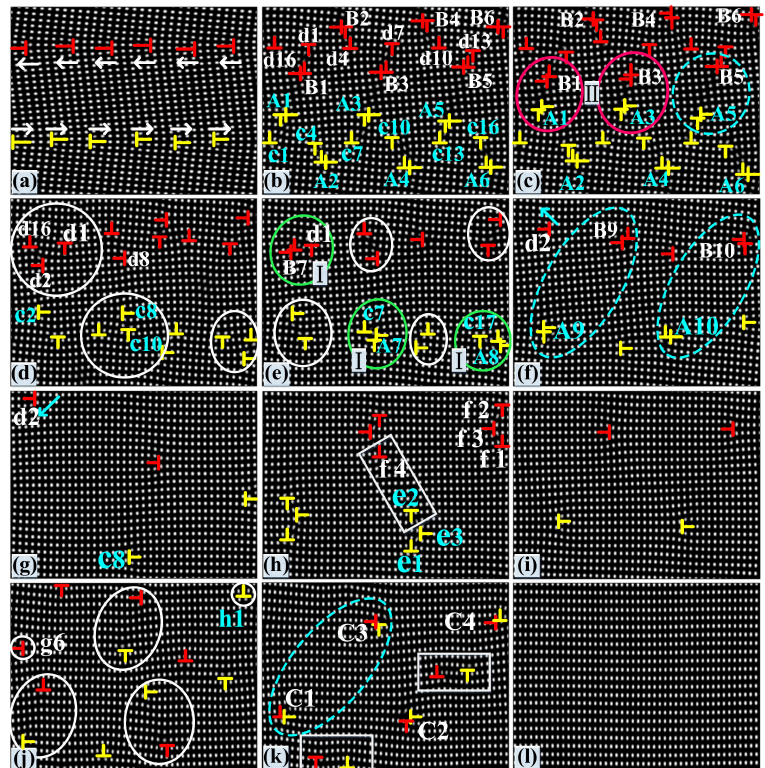
Figure 7. The evolution of the dislocations in sample B. The ( a – l ) corresponding time steps are t * = 38,000; t * = 48,100; t * = 48,200; t * = 48,700; t * = 49,000; t * = 49,600; t * = 55,300; t * = 67,200; t * = 68,000; t * = 79,600; t * = 81,200; and t * = 86,000. The pink solid circle area is a type II semi- annihilation dislocation reaction; the full-annihilation of the dislocation pairs occurs in the blue dotted line area. Type I semi-annihilation occurs in the green solid line area, and new dislocation pairs will form within the white solid coil. Inside the white box is the annihilation of single edge